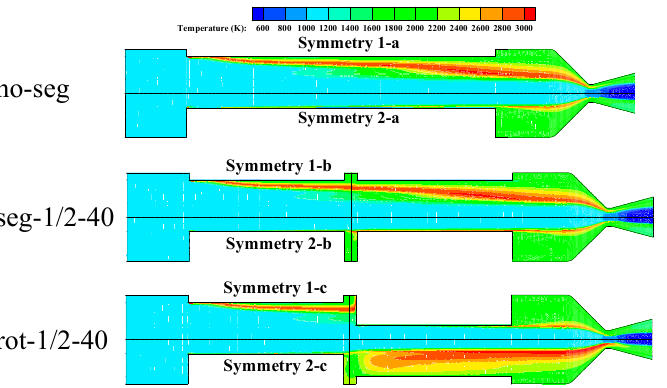
Figure 16. Temperature distributions in symmetry planes for different cases.